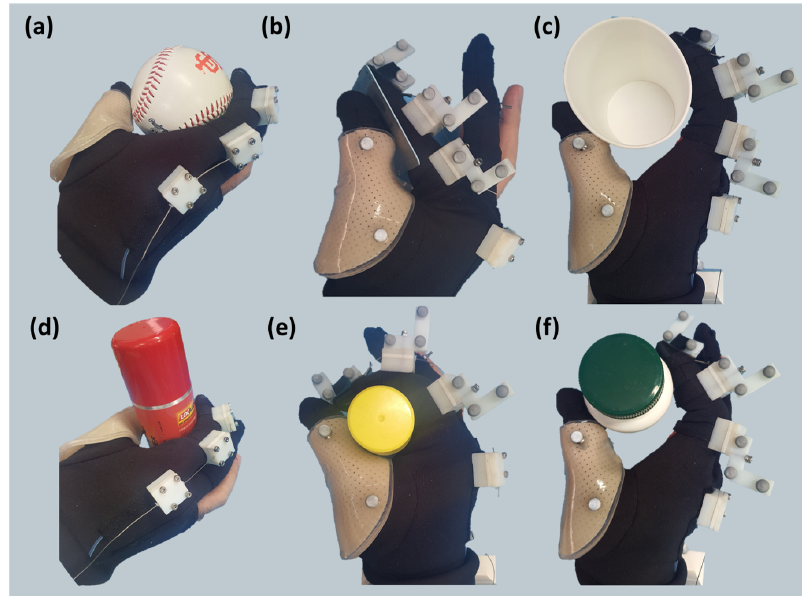
Figure 12. Various postures with the assistance of Exo-Index. With assistance of the proposed robot, three types of grasp postures are established depending on the object size and shape. ( a ) and ( d ) show the posture using the Exo-Index. For more detail, ( b ) shows how card is grasped using narrow pinch while ( e ) shows how glue is grasped with caging. In addition, ( c ) and ( f ) show wide pinch and the grasped objects are paper cup and bottle.